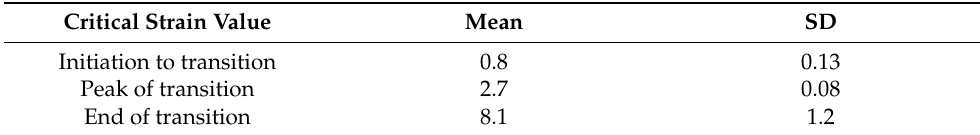
Figure 3. Creep test results of single-layered PSA under 50 kPa and 70 ◦ C. Table 1. Strain value to critical locations of the creep